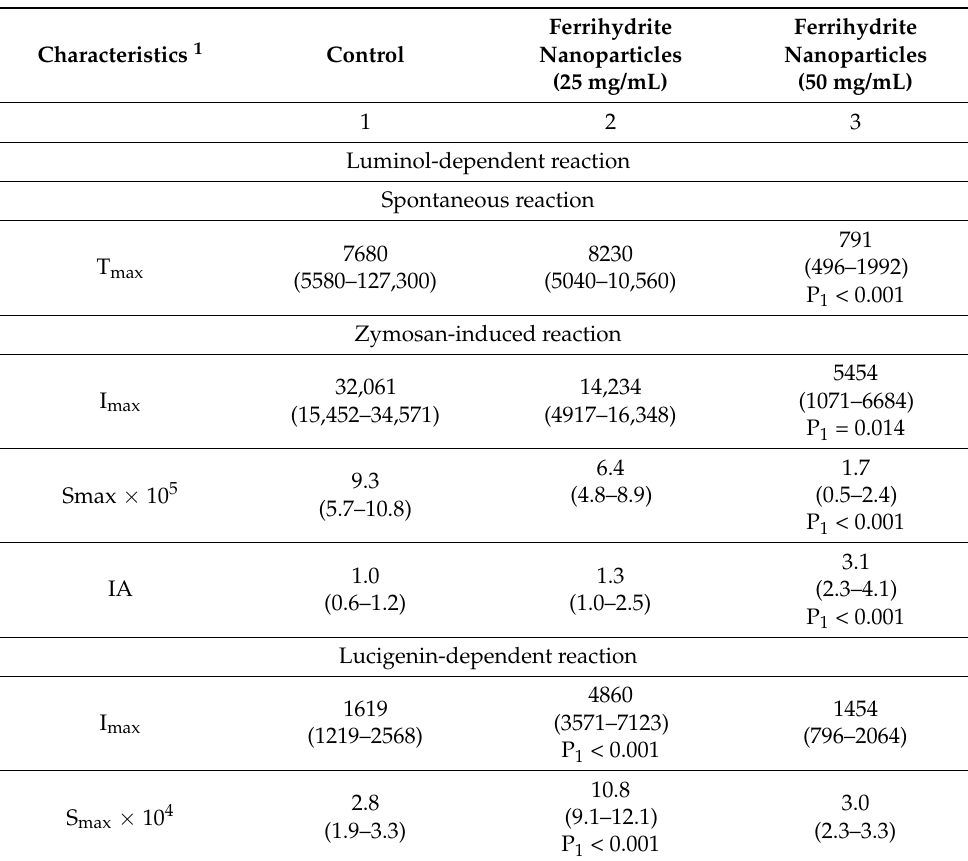
Table 2. Indicators of luminol-and lucigenin-dependent chemiluminescence of neutrophil granulo- cytes under the influence of different concentrations of ferrihydrite nanoparticles with